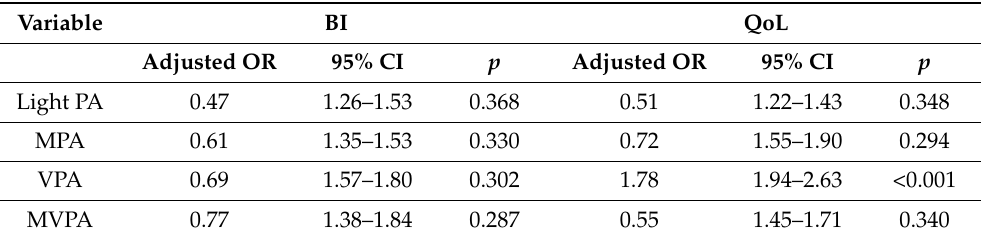
Table 4. Results of correlations between variables for older adults with financial status and education as